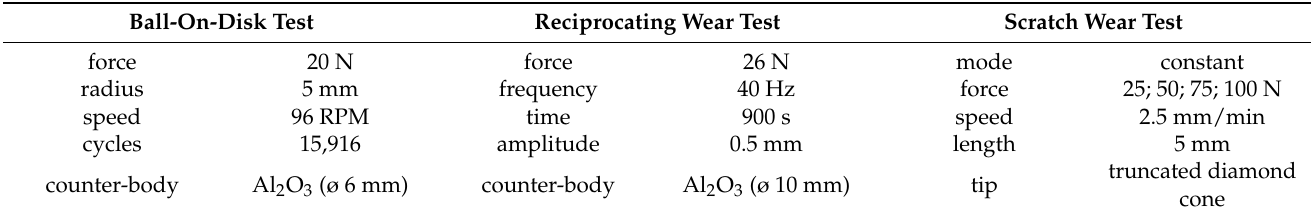
Table 3. Parameters for wear testing under different load